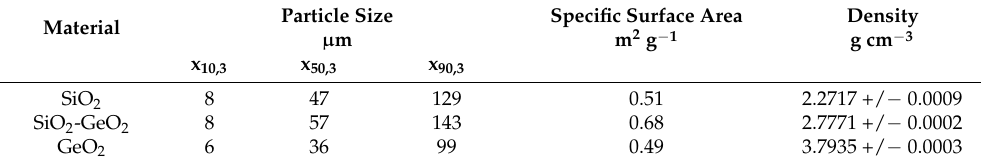
Table 2. Characteristics of the glasses used for comminution experiments.